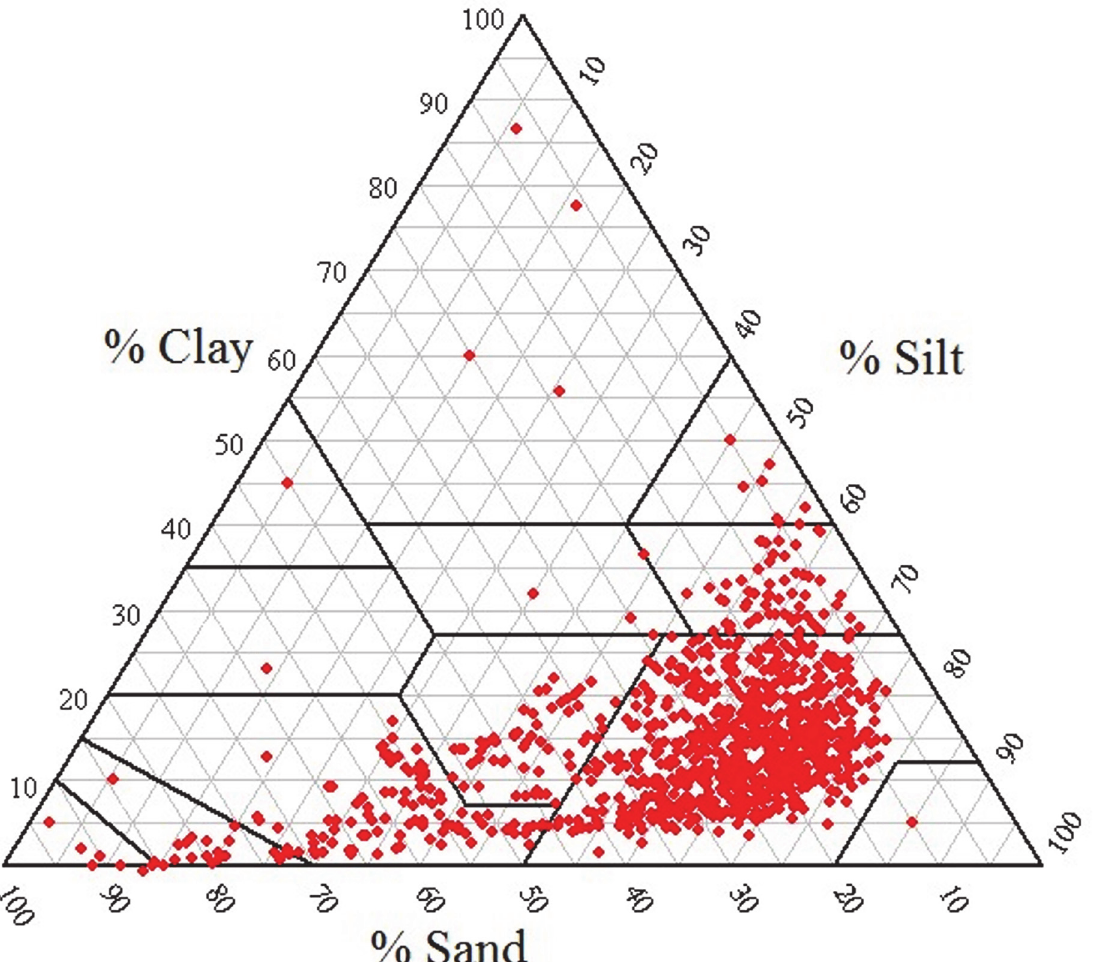
Fig 1. Textural composition of soil